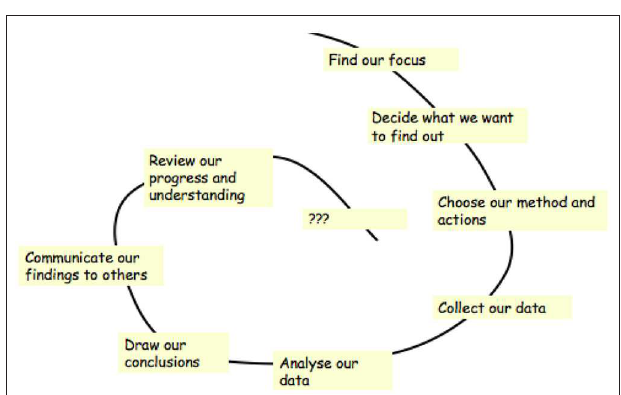
FIGURE 2 | Inquiry learning framework presented as a spiral